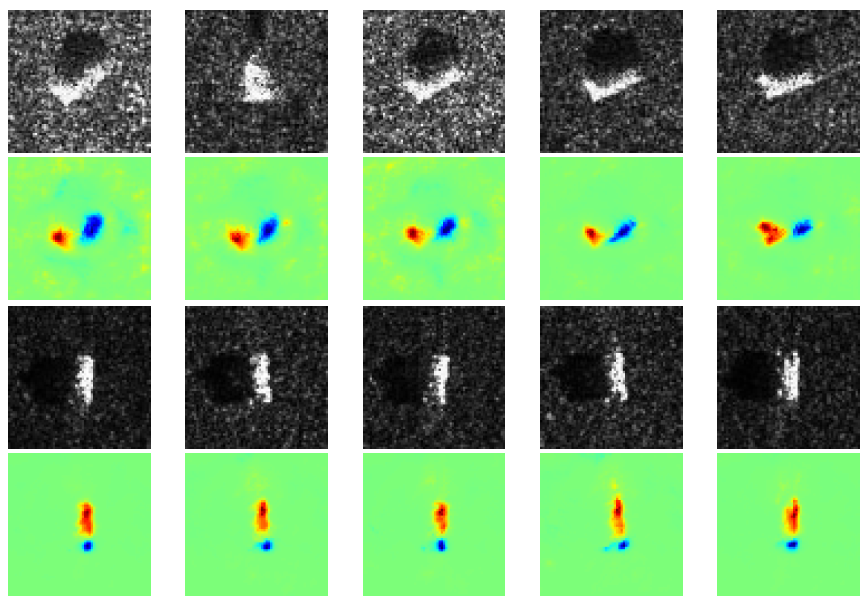
Figure 7. Positive and negative contributions are the targets. The first and third row are SAR images of two classes: 2S1 and SN_132. The second and fourth row are the corresponding heatmaps generated by our method.